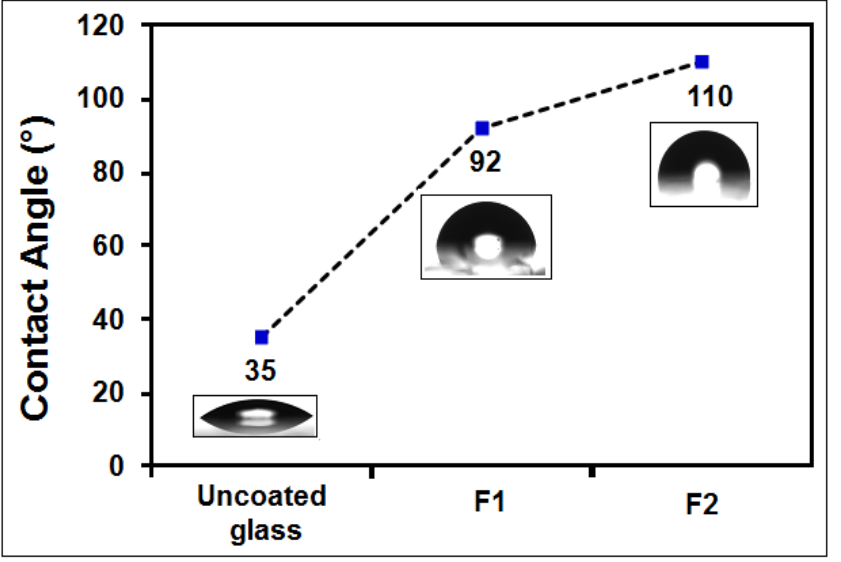
Figure 10. Values of the water contact angles and profiles of the water drops on the uncoated glass and the fluorinated hybrid coatings (TEOS/MTES/FS (F1) and TEOS/MTES/HDTMES/FS (F2)). and the fluorinated hybrid coatings (TEOS/MTES/FS (F1) and TEOS/MTES/HDTMES/FS